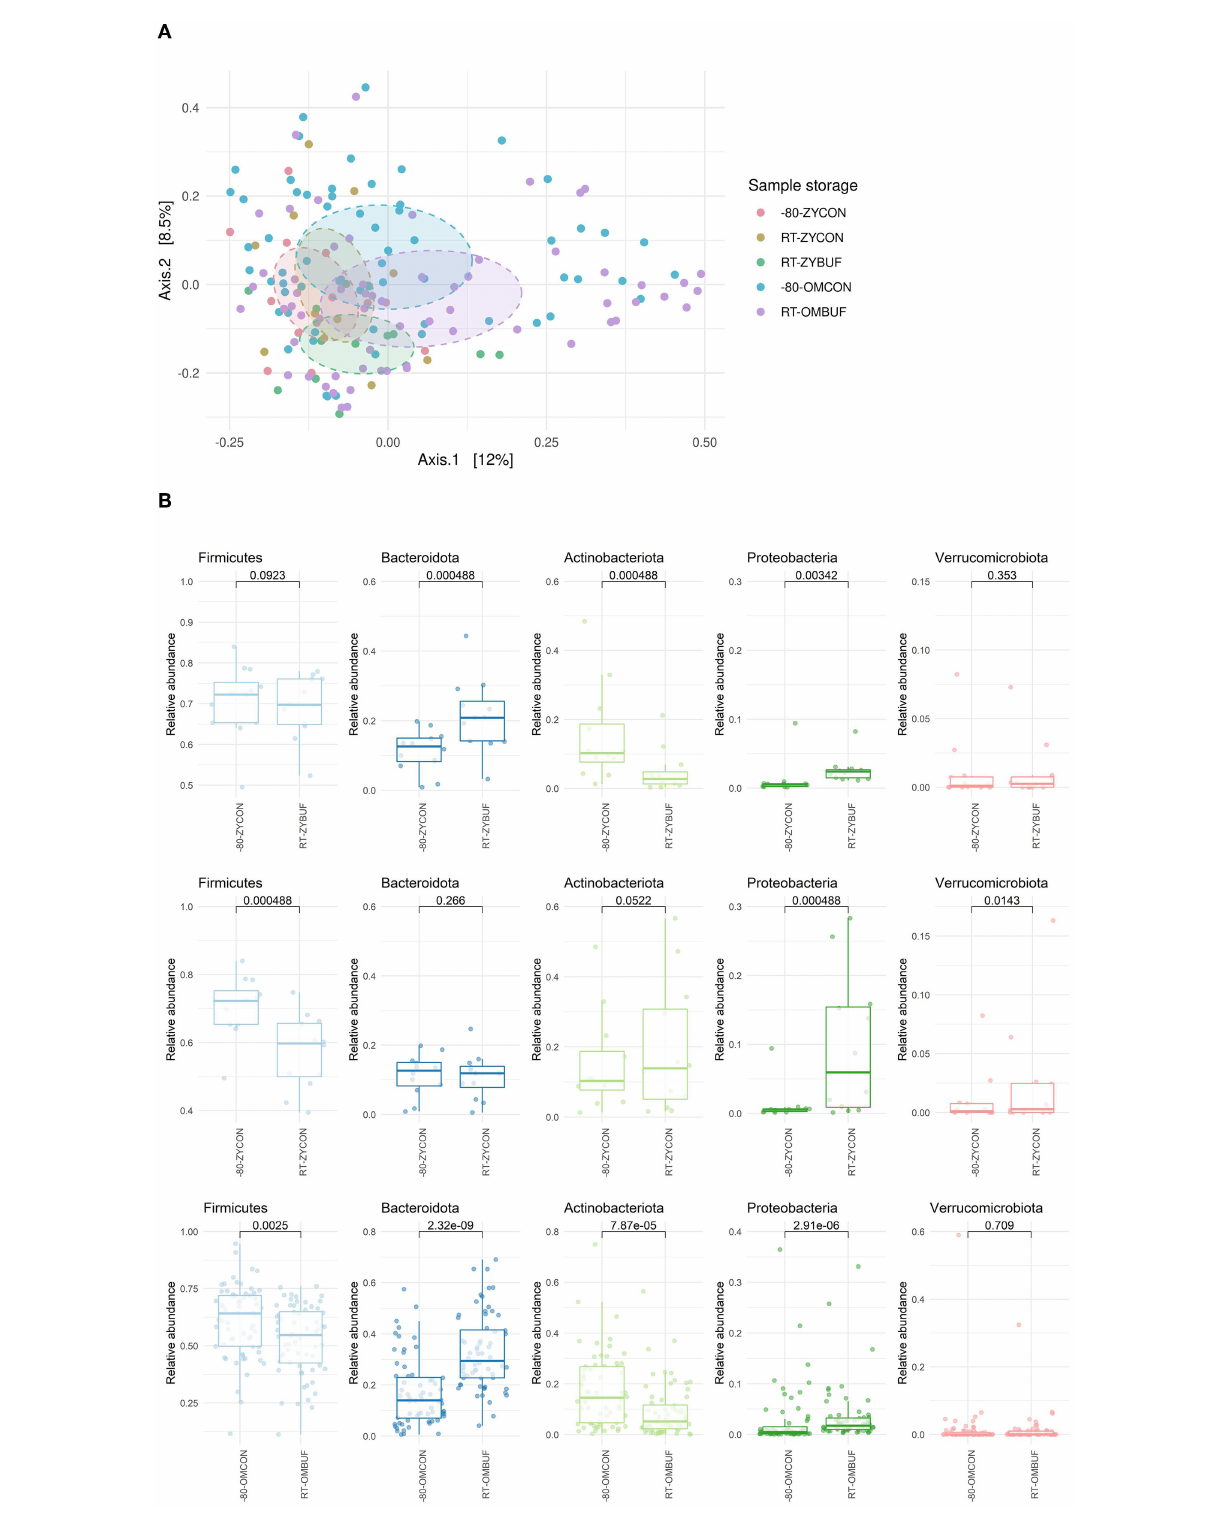
FIGURE3 (A) Beta-diversity on sample collection and storage. Bray–Curtis distance in a PCoA ordination showed a limited effect on sample collection, only significant for samples stored in the OMNIgene · GUT tubes. PERMANOVA testing was performed to test the difference between the two studies ( R 2 = 0.026; p -adjusted = 0.001), and the type of stabilization buffer compared to the frozen control: OMNIgene · GUT tubes ( R 2 = 0.020; p = 0.002) and Zymo research tubes ( R 2 = 0.046; p -adjusted = 1 for RT-ZYBUF, R 2 = 0.032; p -adjusted = 1, for RT-ZYCON). (B) Boxplots show the relative abundance of the five top most abundant phyla. The differences between the storage conditions were tested with the Wilcoxon